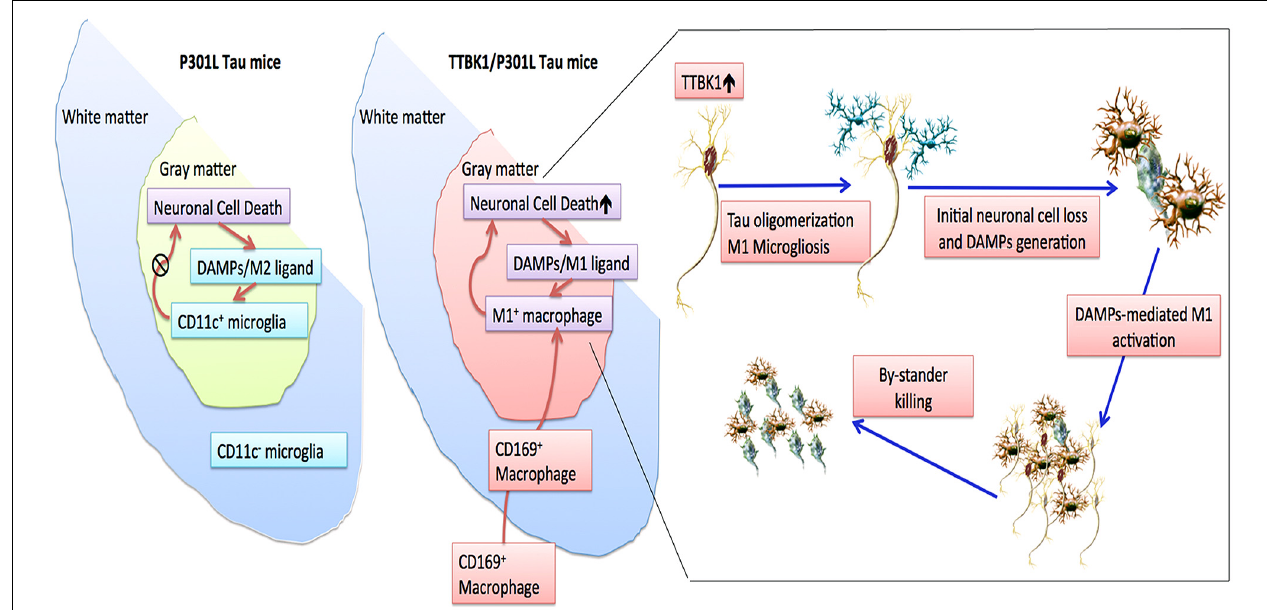
FIGURE 4 | Scheme of neuroinflammation and neurodegeneration in JNPL3 and TTBK1/JNPL3 mice. In JNPL3 mice, CD11c + neuroprotective microglia accumulate in the gray matter of the ventral horn, thereby protecting from accelerated neurodegeneration. Conversely, in